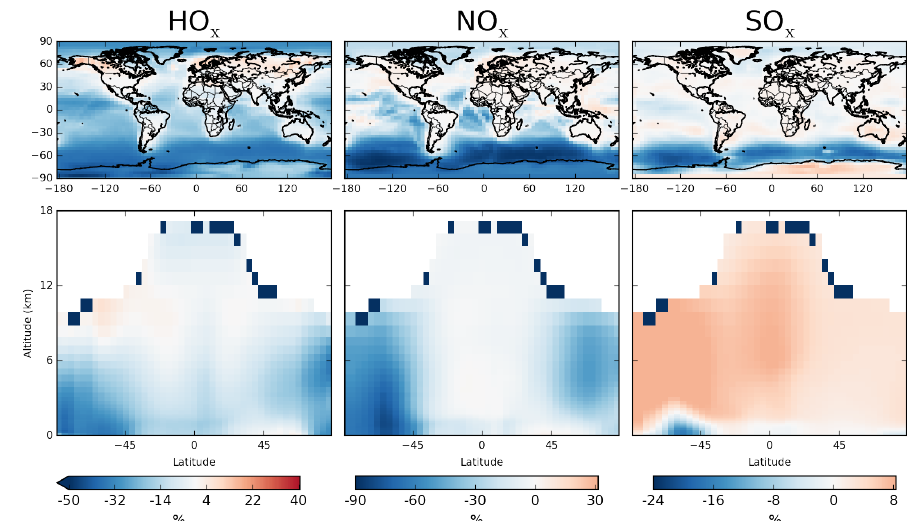
Figure 18. Global annual-average surface and zonal change (%) in HO x , NO x , and SO x families (as defined in Appendix C) on inclusion of halogens.